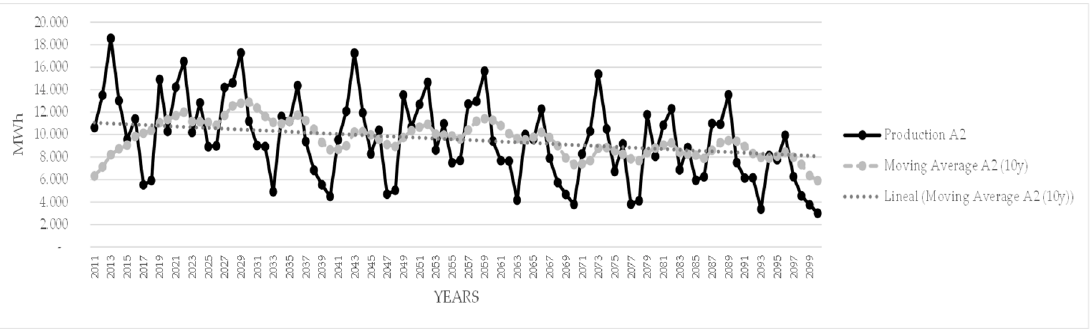
Figure 6. Projected production for Cala in MWh (A2).